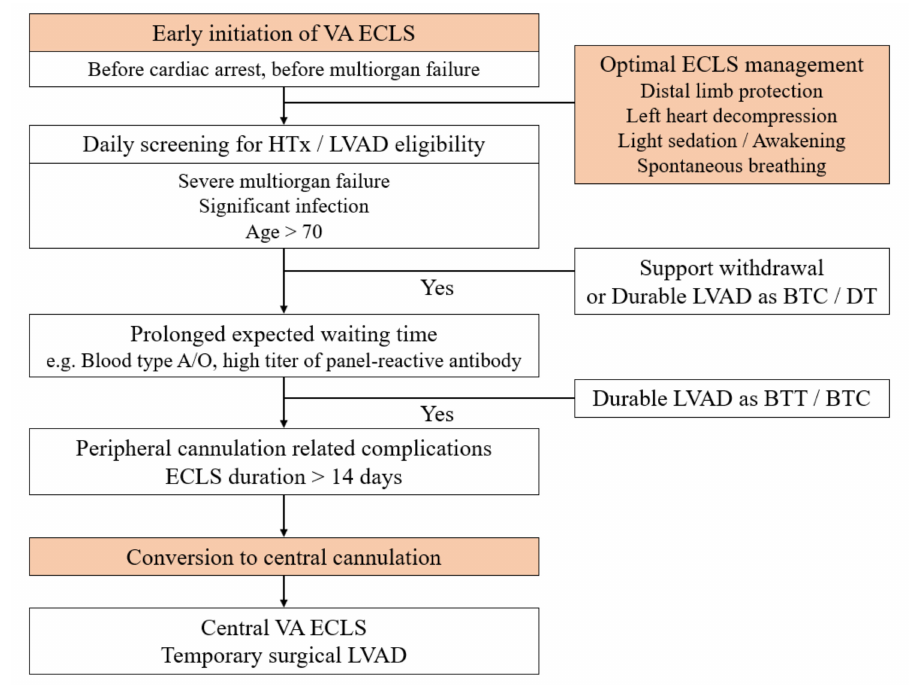
Figure 3. The recent strategy of ECLS as BTT in our institution. ECLS, extracorporeal life support; BTT, bridge to transplantation; VA, venoarterial; HTx, heart transplantation; LVAD, left ventricular assist device; BTC, bridge to candidacy; DT, destination